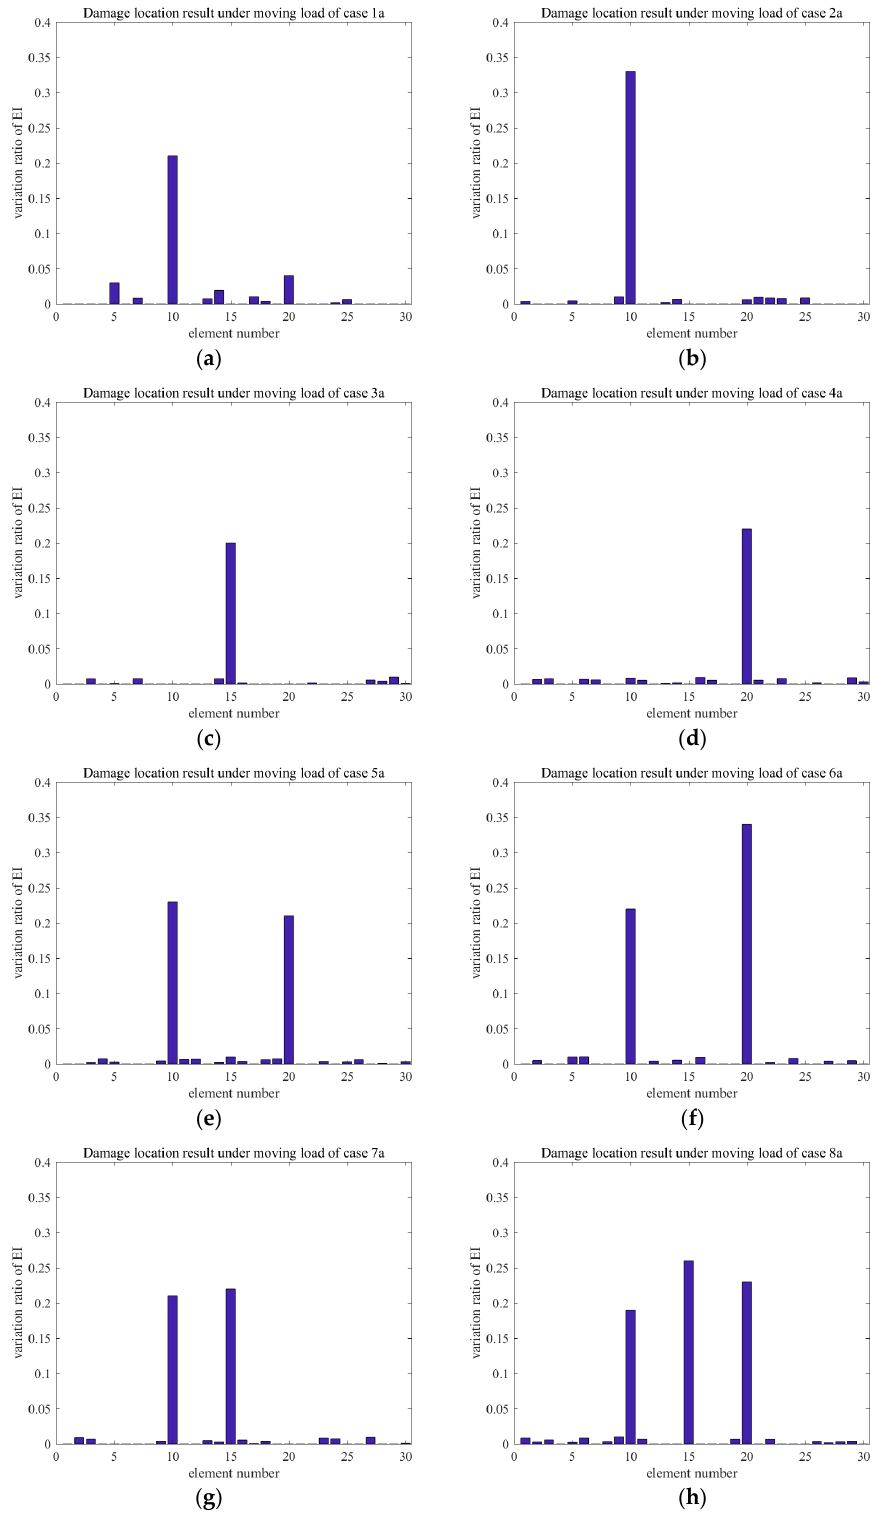
Figure 15. Damage location results under moving load of Group A: ( a ) DMG1a; ( b ) DMG2a; ( c ) DMG3a; ( d ) DMG4a; ( e ) DMG5a; ( f ) DMG6a; ( g ) DMG7a; and, ( h )